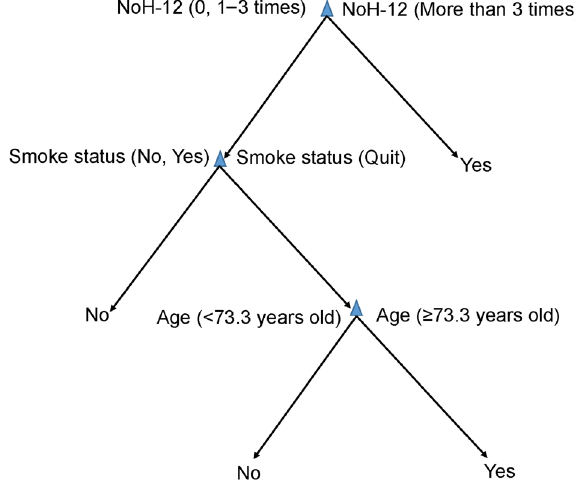
Fig. 4 Visualization of the decision tree in a fl owchart-like structure. The decision rule has a hierarchical, tree structure consisting of a root node, branches, internal nodes and leaf